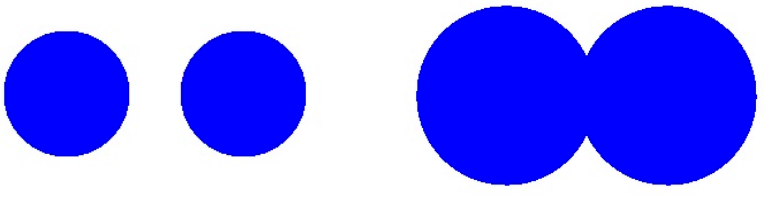
Figure 4. Cross integration of two interfaces.